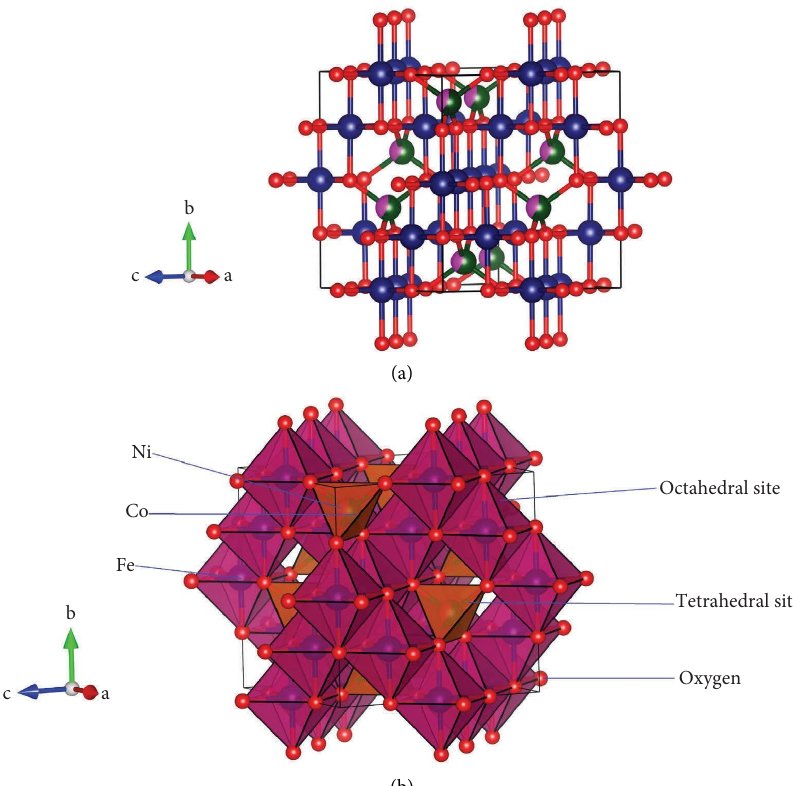
Figure 8: Typical polyhedral model crystal structure of Co 0.6 Ni 0.4 Fe 2 O 4 : (a) ball and stick model and (b) polyhedral model.